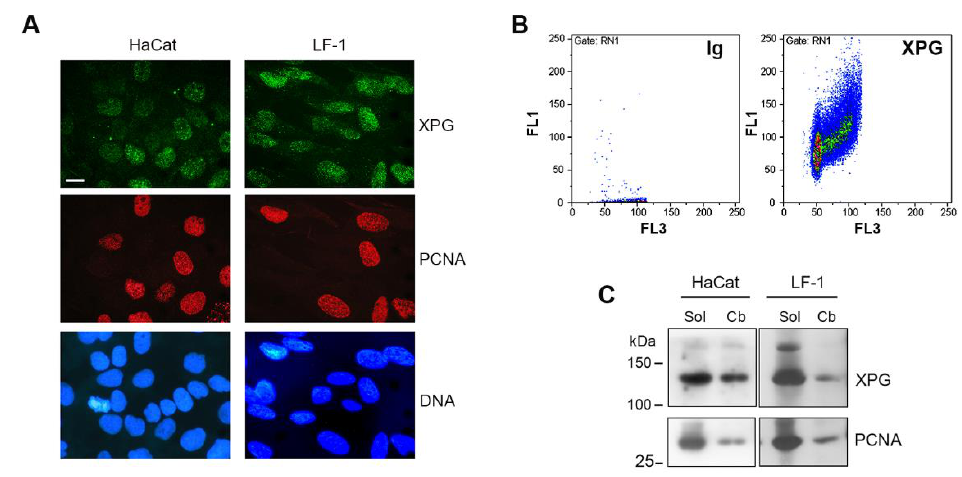
Figure 1. ( A ) Immunofluorescence of chromatin-bound form of XPG and PCNA proteins in HaCaT keratinocytes and in LF-1 fibroblasts. Cell grown on coverslips were subjected to in situ detergent extraction and fixed as described in Materials and Methods. XPG (green fluorescence) and PCNA (red fluorescence) shown with DNA (blue fluorescence). Scale bar = 10 μm. ( B ) Flow-cytometry dual-parameter analysis of cell-cycle distribution of chromatin-bound XPG in HaCaT cells. Immunofluorescence (FL1) was detected on cells stained with secondary antibody only (Ig), or with anti-XPG specific antibody, and counterstained with propidium iodide (PI) for DNA content (FL3). ( C ) Western blot analysis of detergent-soluble (Sol) and chromatin-bound (Cb) fractions of XPG and PCNA in HaCaT keratinocytes and LF-1 fibroblasts.